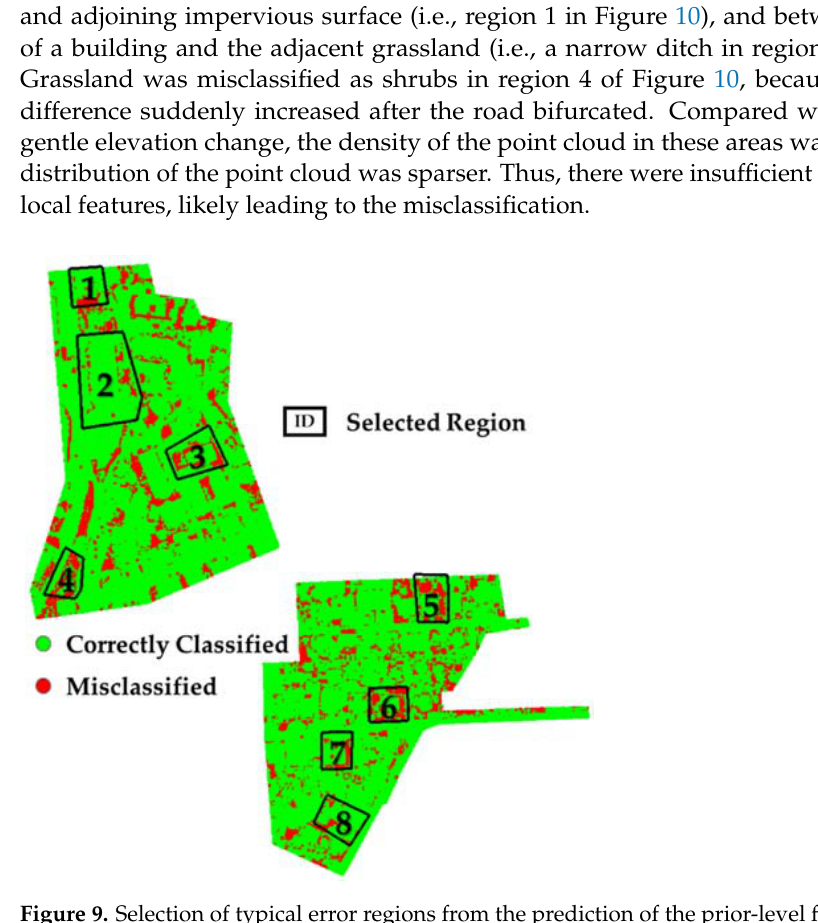
Figure 8. Training loss and testing loss during SegNet training.